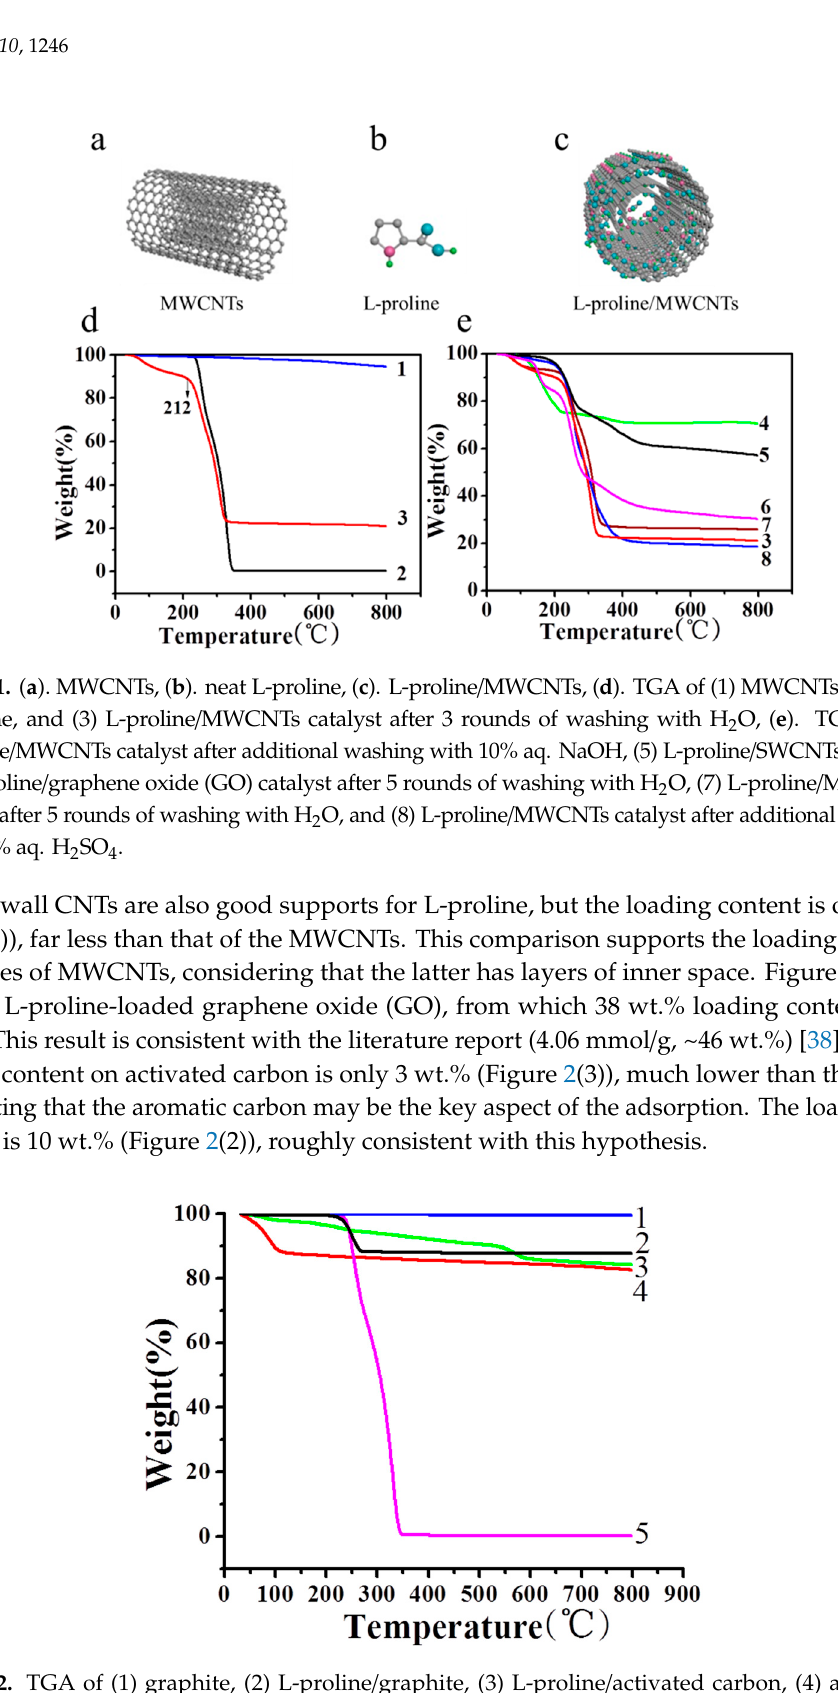
Figure 2. TGA of (1) graphite, (2) L-proline / graphite, (3) L-proline / activated carbon, (4) activated carbon, and (5) neat L-proline. The weight loss of L-proline was measured in its decomposition range of 229–347 ° C.